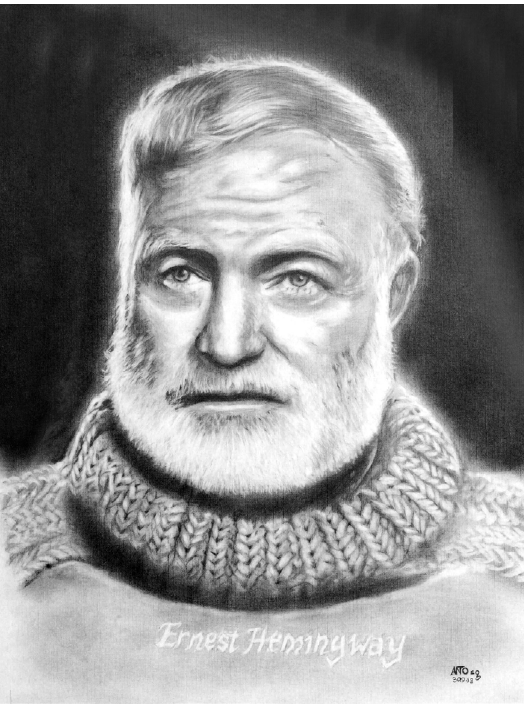
Supplementary images: Other Anto's paints . Not included in the covers.